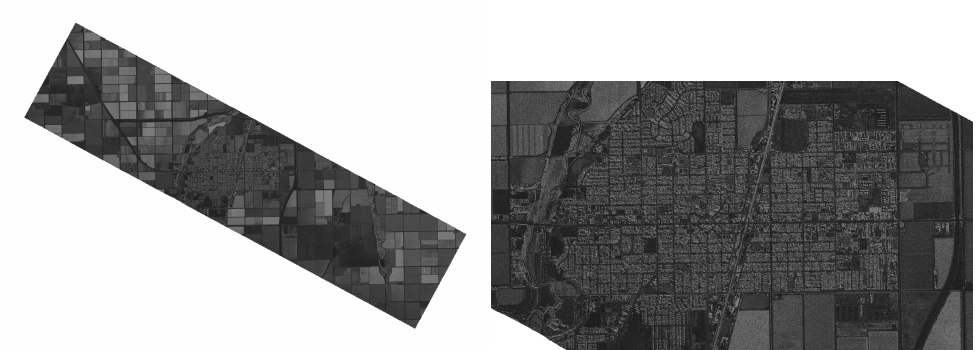
Figure 1. Example SAR image from 115.5 ◦ W 32.9 ◦ N WGS84 (Brawley US) from Capella Open Data, with zoom on the city in the middle.